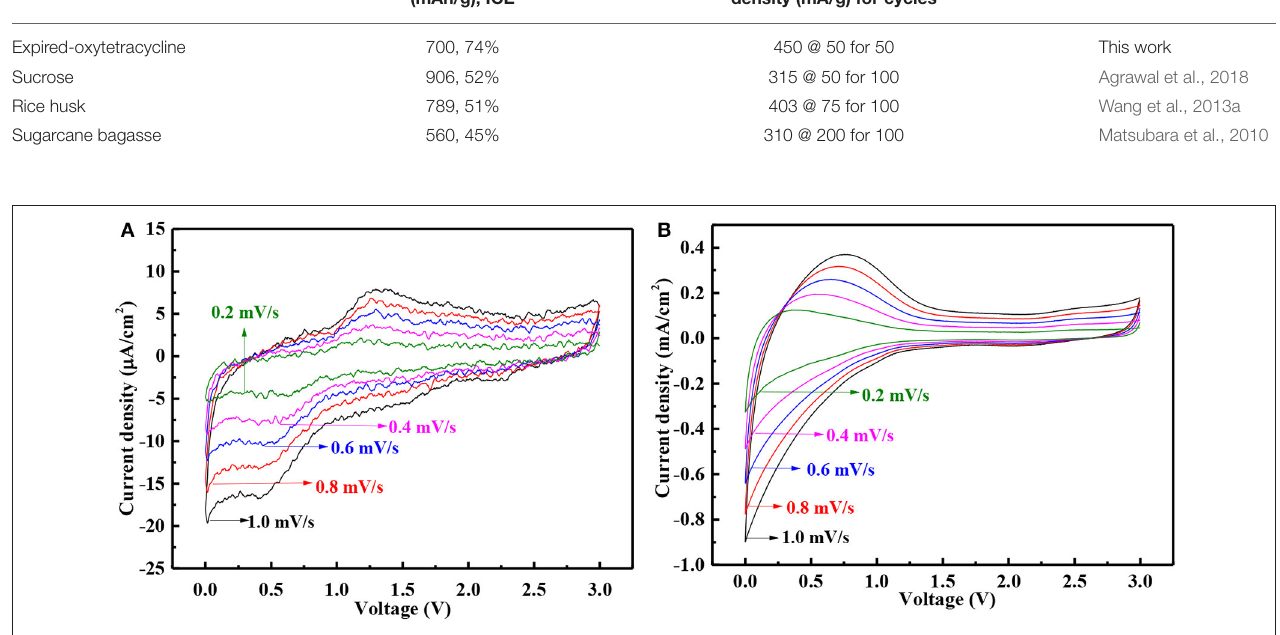
FIGURE 7 | CV curves at different scanning rates of (A) expired oxytetracycline anode and (B) expired-oxytetracycline-derived carbon anode.